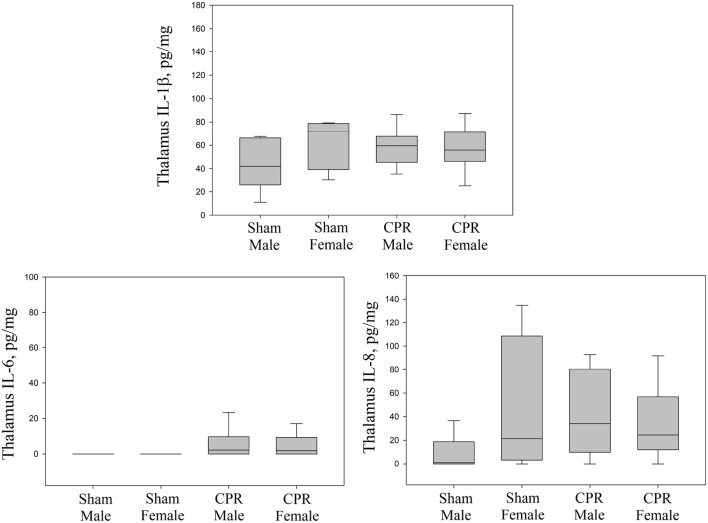
Concentrations of IL-1β, IL-6, and IL-8 in thalamus homogenates, expressed relative to protein concentration, in sham female (n = 5) and male piglets (n = 13) and female (n = 28) and male (n = 49) piglets receiving resuscitation. Results represent the median (solid bar), IQR (box margin), and 95% confidence interval.